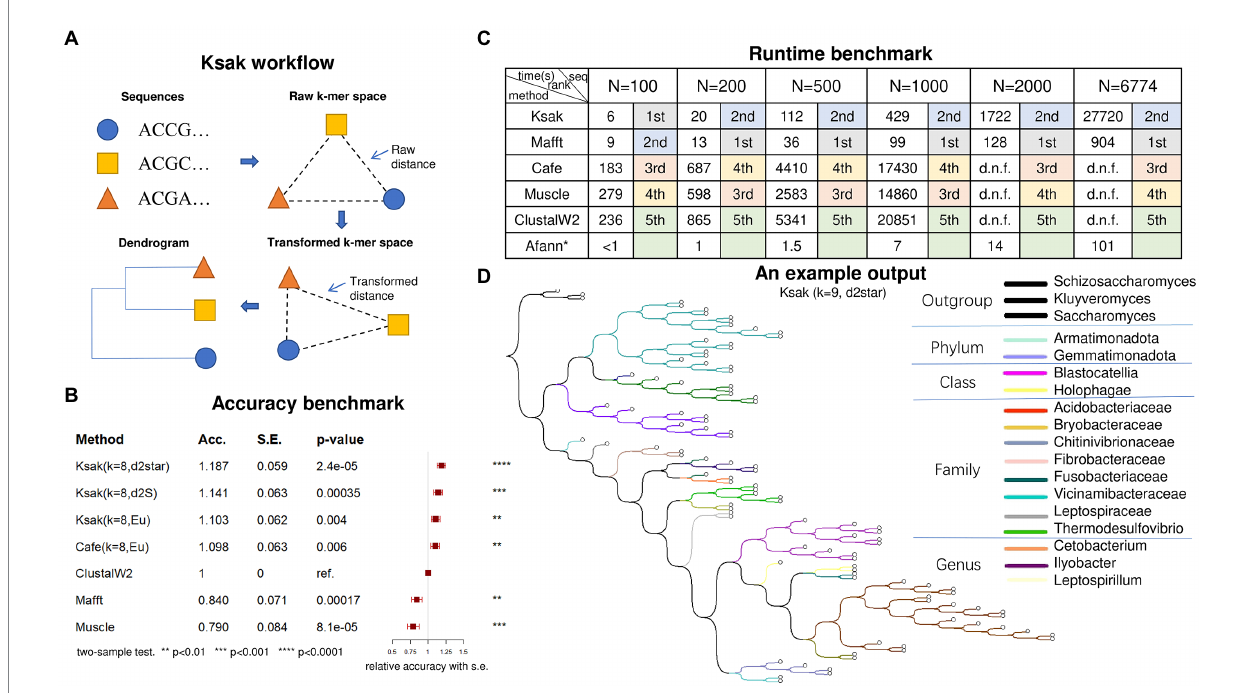
FIGURE 1 (A) The computation framework of Ksak ; (B) Accuracy benchmark results; (C) Efficiency benchmark results; (D) An example phylogeny tree output of Ksak